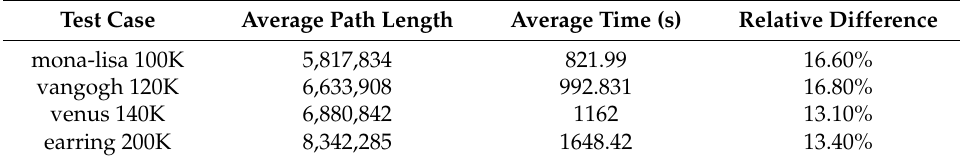
Table 6. Results of algorithm runs with infinite norm.